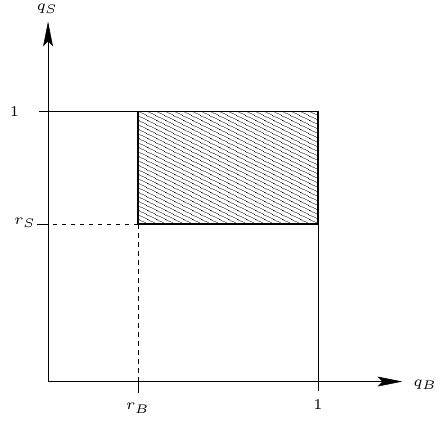
Figure 1. The region in which Ally-Ally is a Nash equilibrium when improved market performance is available.